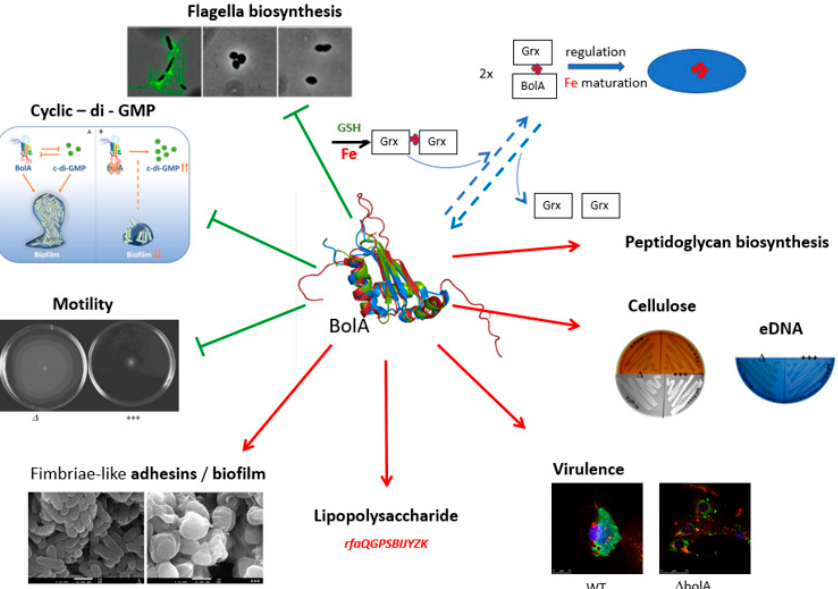
Figure 3. Pleiotropic effects of E. coli BolA. In green are represented features/mechanisms repressed by BolA. Mechanisms promoted by BolA can be seen in red. Blue arrows represent the role of BolA in iron homeostasis, a pathway that is still not well understood. The cartoon in the center represents superposition of BolA NMR structure of three BolA proteins (B): E. coli (PDB ID 2DHM, red): C. burnetti (PDB ID 3TR3, green), B. bovis (PDB ID 3O2E, blue) [14].